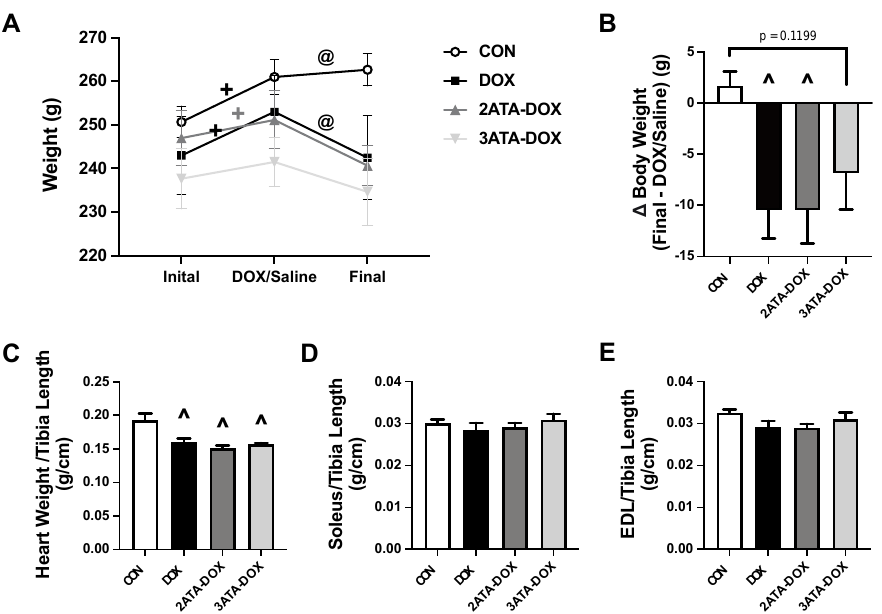
Figure 2. Body and Muscle Weights. Measurements of ( A ) change in group weight over the experi- mental timeline; ( B ) change in body weight (Final-DOX/Saline); ( C ) heart weight; ( D ) soleus weight; and ( E ) EDL weight. Muscle weights were all normalized to tibia length. Values are represented as means ± SEM. + = significantly different vs. Initial ( p < 0.05). @ = significantly different vs. DOX/Saline ( p < 0.05). ˆ = significantly different vs. CON ( p < 0.05).